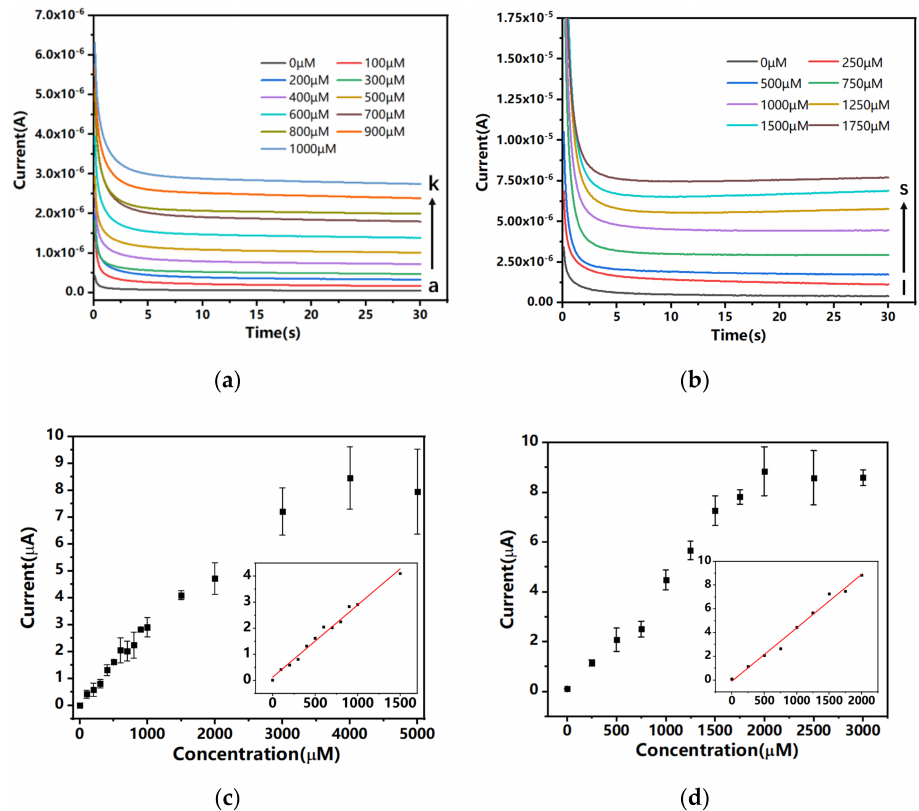
Figure 4. Amperometric I-t curves of the dual-channel biosensor in different concentrations of ( a ) glu- cose and ( b ) lactate solutions. ( c ) Steady-state currents plotted as functions of glucose concentration. The insert shows the linear curve fitting between response currents and glucose concentrations, coefficient of association R 2 = 0.9860 ( N = 3). ( d ) Steady-state currents plotted as functions of lac- tate concentration. The insert shows the linear curve fitting between response currents and lactate concentrations, coefficient of association R 2 = 0.9876 ( N =